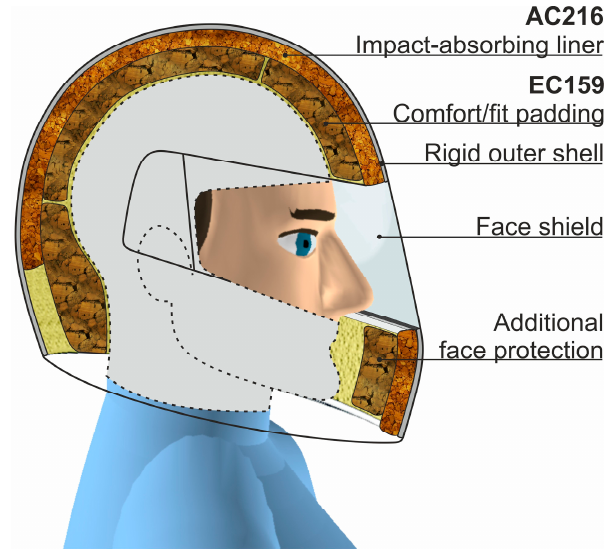
Figure 1. The cross-section of a motor helmet where cork sandwiches have been applied.